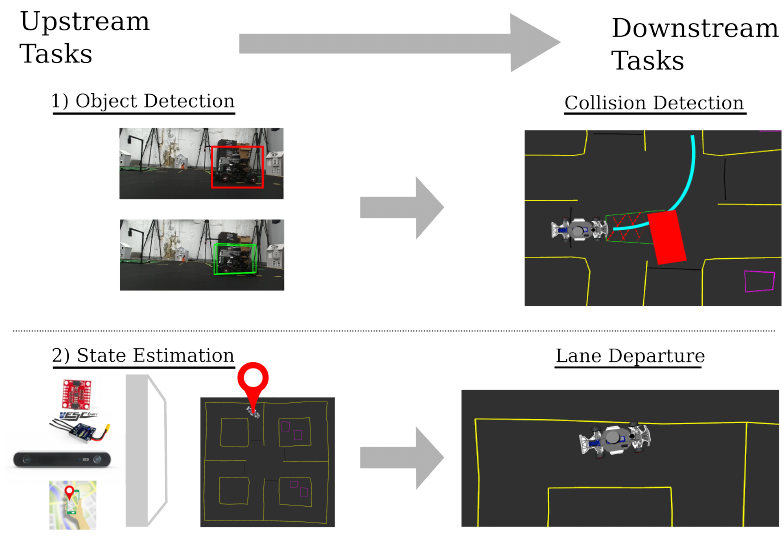
Figure 9. Upstream and Downstream Perception